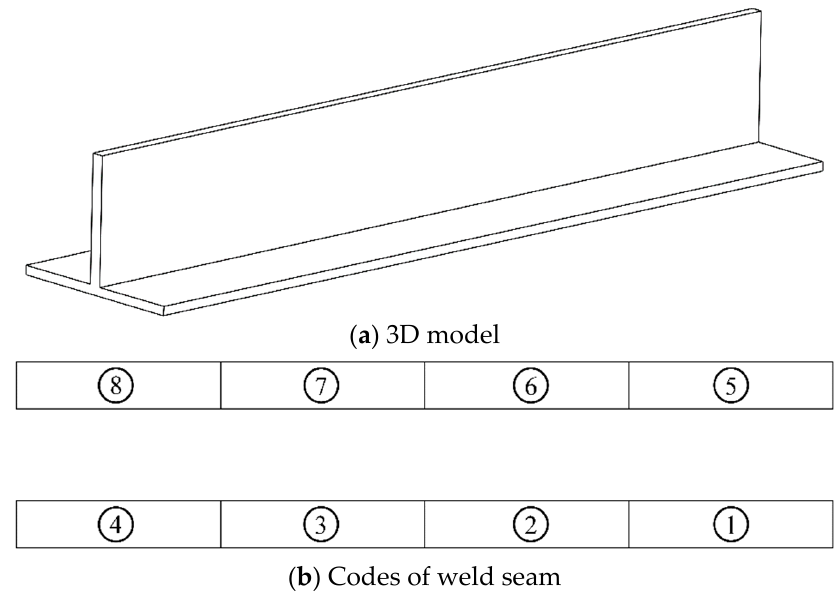
Figure 7. Weld seam coding of welded structure 1.